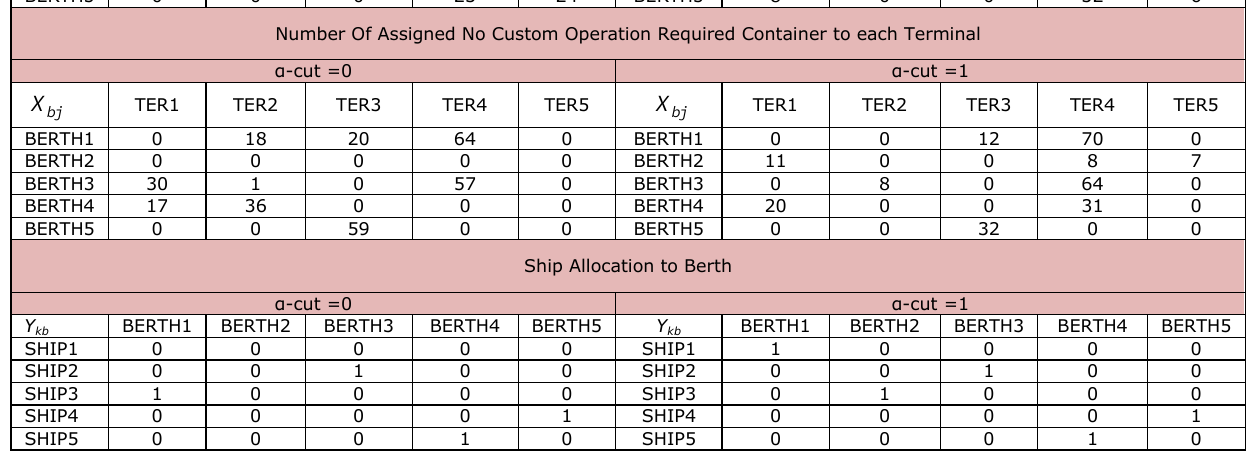
Table 7. “Solution Structure for Pessimistic